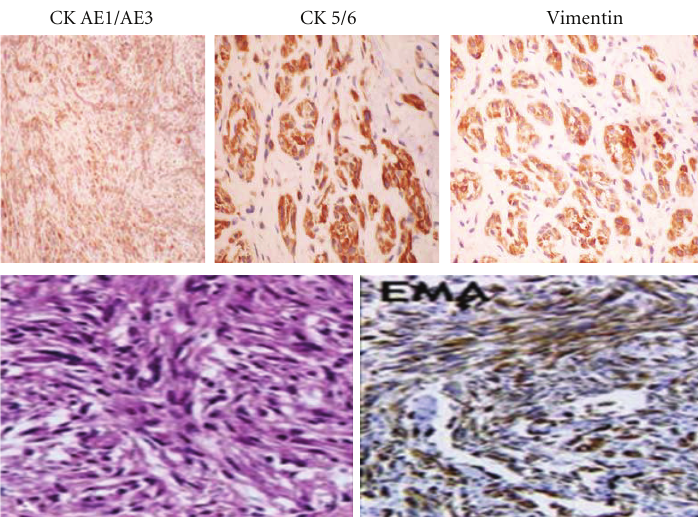
Figure 3: Immunohistochemistry: cytokeratin AE1/AE3, strongly positive di ff use nuclear staining of neoplastic cells, Ck 5/6, strongly positive nuclear cytoplasmic staining of neoplastic cells, vimentin, strongly positive. Epithelial membrane antigens (EMA) was positive.